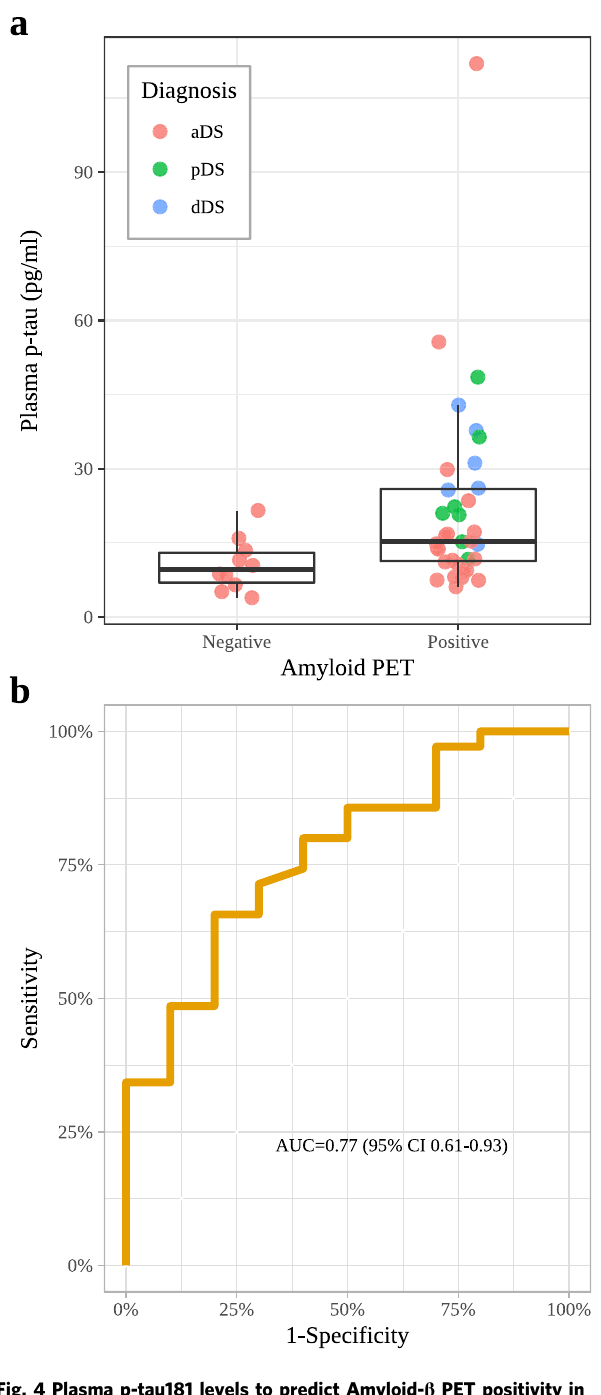
Fig. 4 Plasma p-tau181 levels to predict Amyloid- β PET positivity in Down syndrome. a Plasma p-tau181 levels for Down syndrome subjects strati fi ed by amyloid- β PET status ( n PET negative = 0; n PET positive = 35). The central black lines indicate the median values. The boxes above and below these lines show the upper and lower quartiles, respectively, and the whiskers illustrate upper and lower 1.5× IQR limits. b ROC curves for plasma p-tau181 comparing the individuals with Down syndrome with positive and negative amyloid- β PET. ROC receiver operating characteristic, p-tau tau phosphorylated at threonine